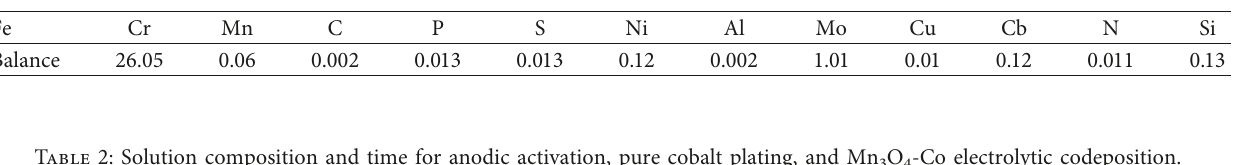
3 O 4 -Co electrolytic codeposition.